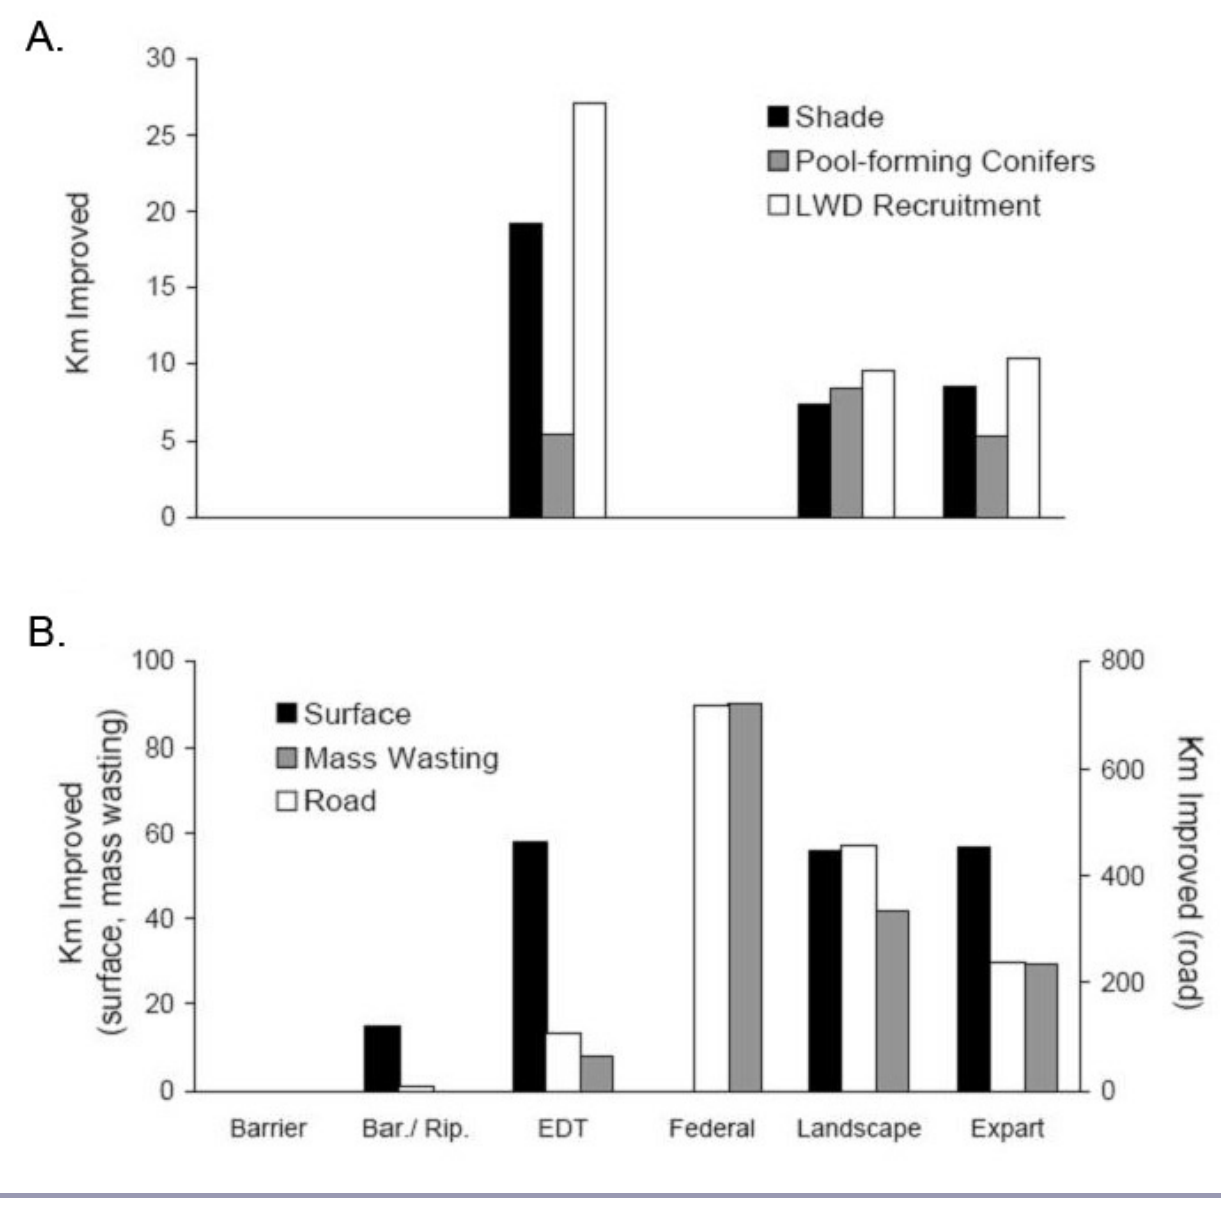
Fig. 5. Detailed descriptions of predicted changes in (A) riparian function and (B) fine sediment inputs across the six watershed management strategies. Predicted responses to the landscape and expert strategies are presented as the average over all modeled landscapes. Note that the y-axis scale changes between metrics; there are two y-axes in panel